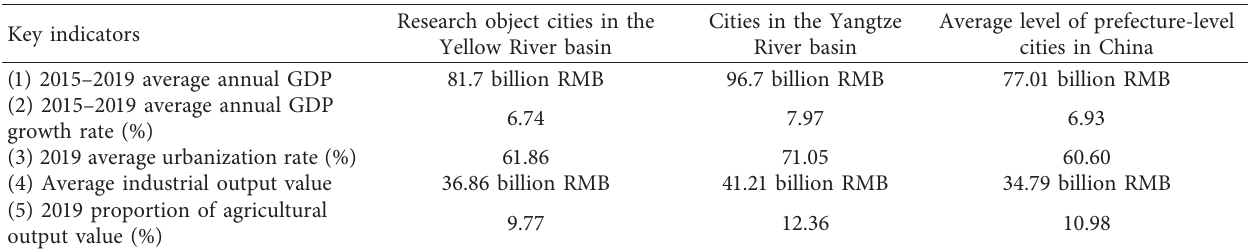
Table 2: Comparison of the key indicators of city development in Yellow River basin, Yangtze River basin, and China’s average